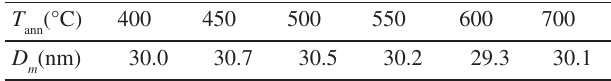
in the Fe Ag granular alloy at difer- m 10 90